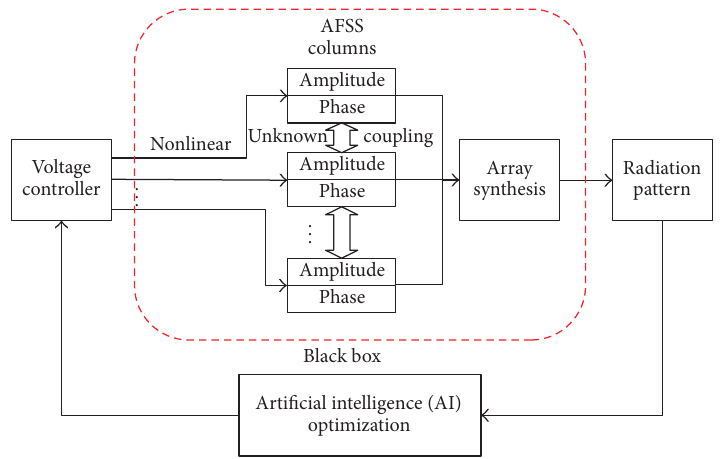
Figure 8: Measured phase response for different